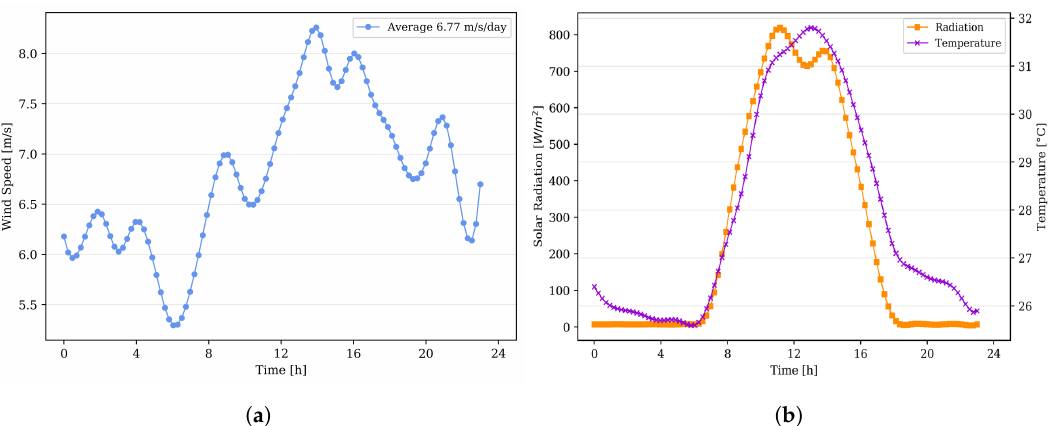
Figure 1. Natural resource profiles in one day in Puerto Bolivar, La Guajira, Colombia [7]. ( a ) Wind speed. ( b ) Solar radiation and temperature.